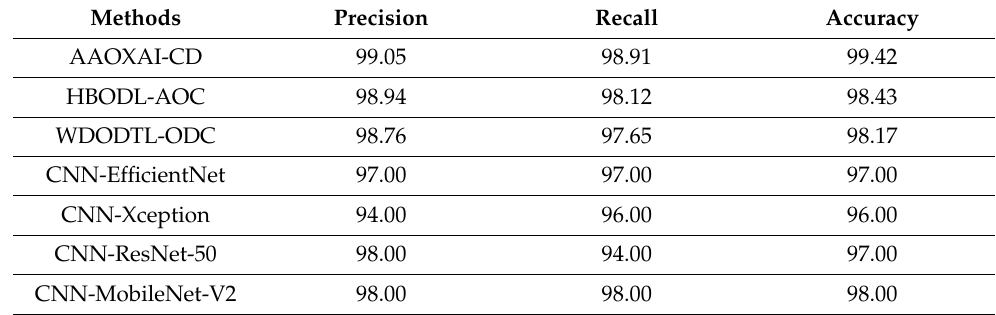
Table 4. Comparative analysis of AAOXAI-CD approach with other systems on dataset-2.